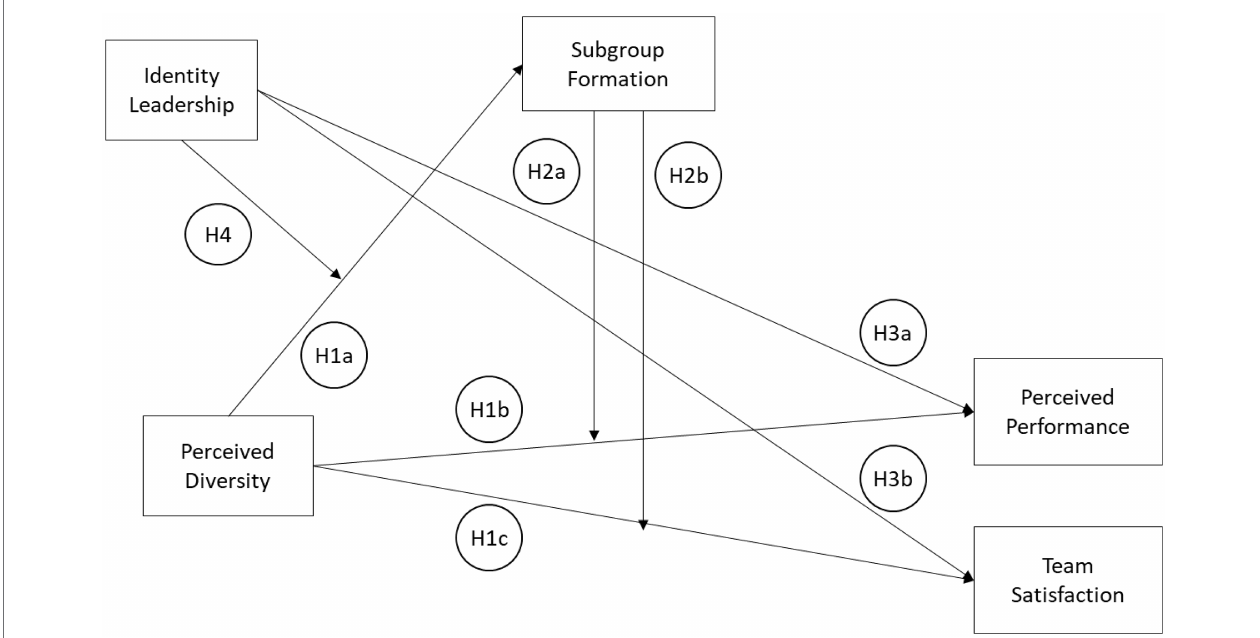
FIGURE 1 | Proposed relationships among the selected